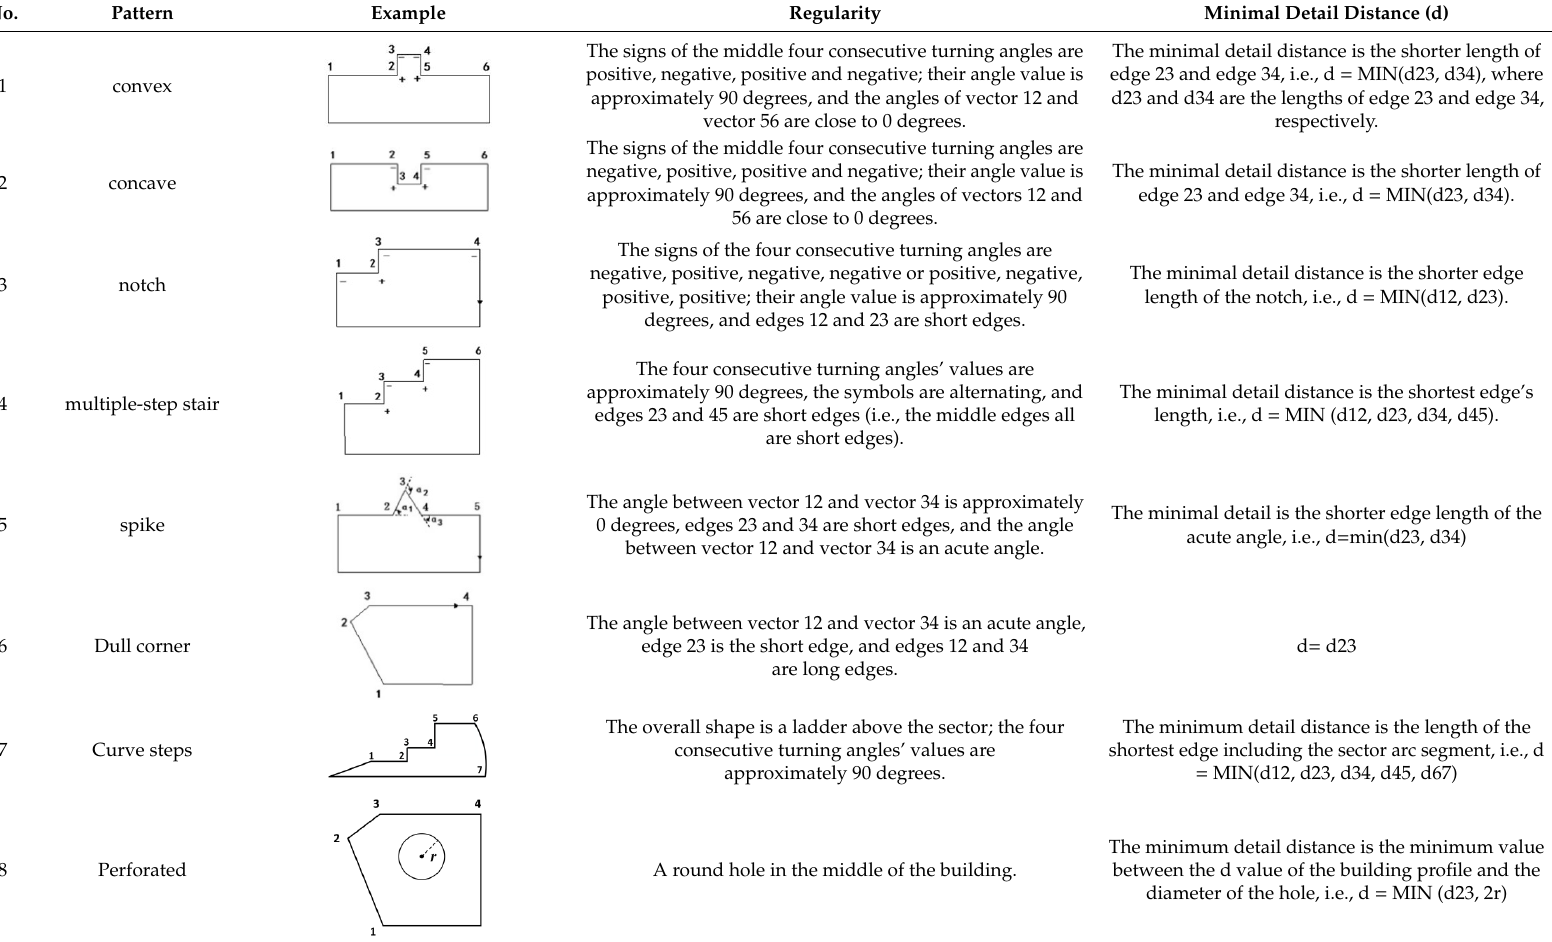
Figure 5. Schematic map of the size and direction of the intersection angle. Table 1. Graphical units, identification methods and LoD parameters of artificial building polygons.